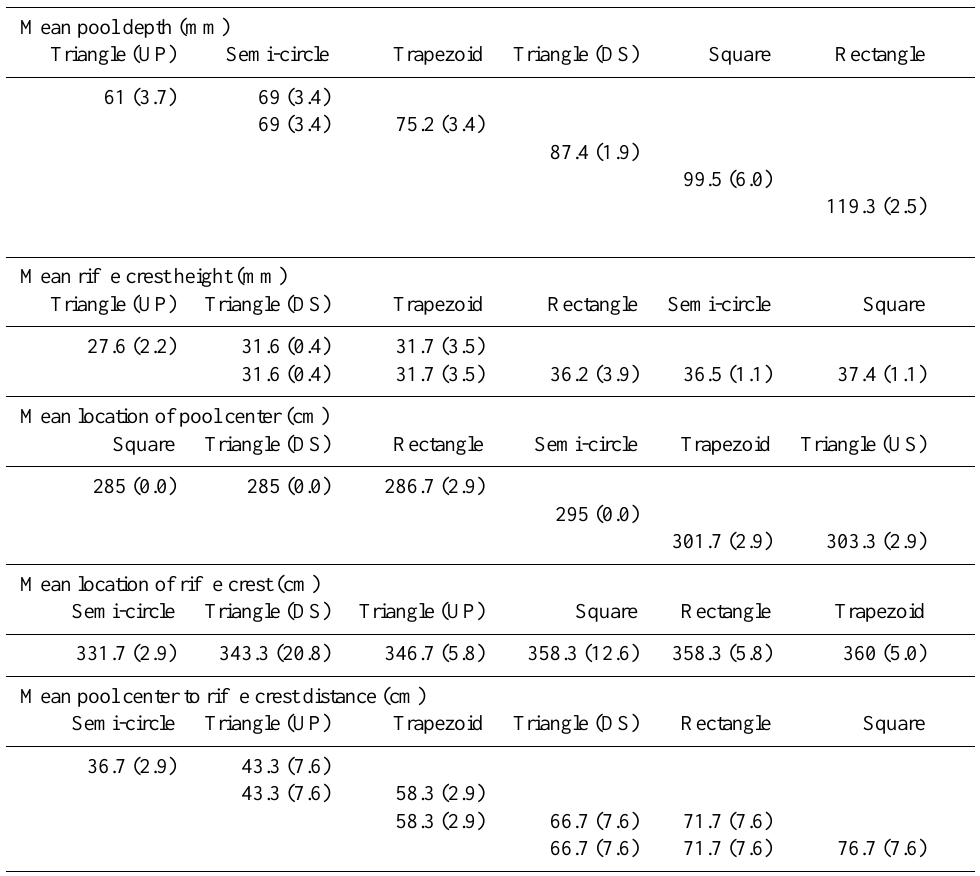
Table 3. Comparison of means results for the five response variables. Mean values contained within the same horizontal line are not significantly different from each other. Values in parentheses are the corresponding standard deviations.